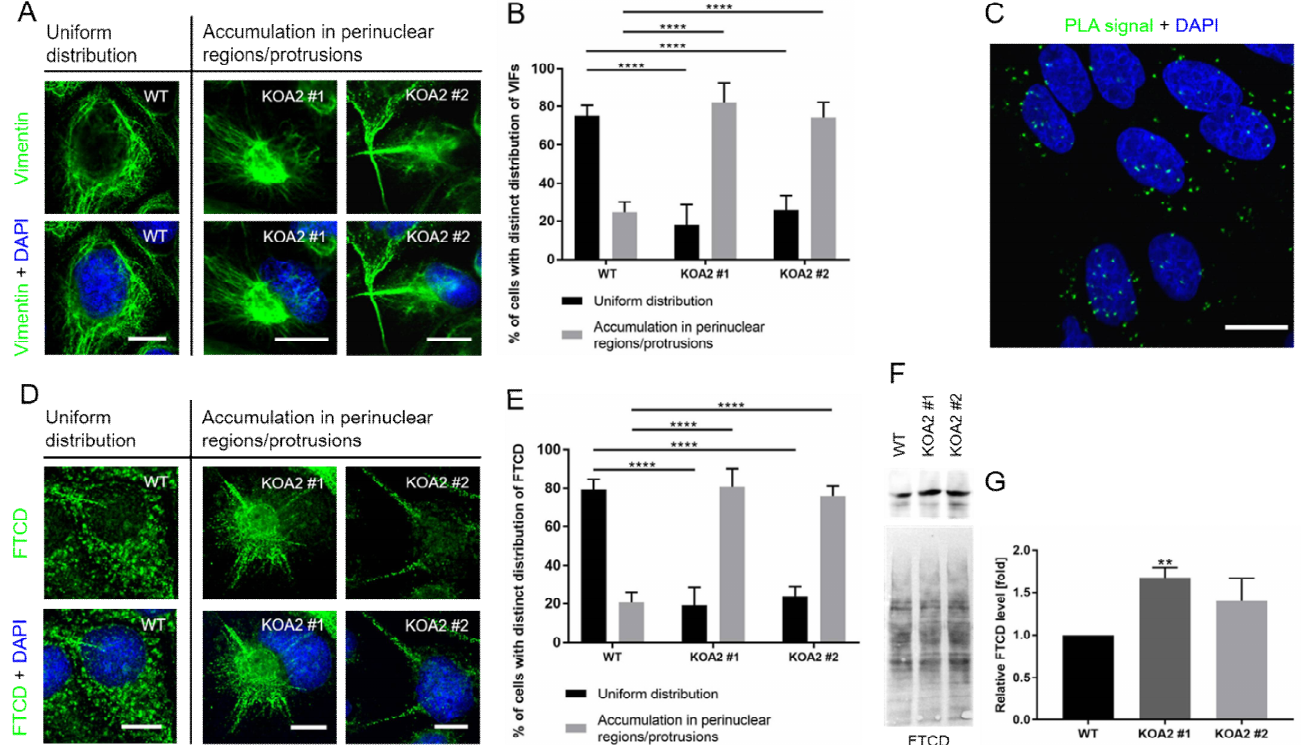
Figure 5. SLC35A2 deficiency affects organization of VIFs. ( A , D ) Representative images of distinct vimentin ( A ) and FTCD ( D ) staining patterns. VIFs ( A ) and FTCD ( D ) are shown in green and cell nuclei are shown in blue. Scale bar corresponds to 10 µ m. The way of data presentation was inspired by [41]. ( B , E ) Quantitative analysis of the percentage of cells with distinct distribution of VIFs ( B ) and FTCD ( E ) in the wild-type and SLC35A2 knockout cells. Data are presented as mean ± SD (6–9 images and 100 cells were analyzed for each cell line). Asterisks indicate statistically important differences between wild-type cells and individual clones. The significance level was set at p ≤ 0.0001 (****). Data were analyzed using ordinary one-way ANOVA with post hoc (Tukey’s multiple comparisons) test. ( C ) Results of in situ PLA analysis of proximity between FTCD and vimentin in the wild-type cells. PLA signals are shown in green and cell nuclei are shown in blue. Scale bar corresponds to 20 μm. ( F ) Western blotting analysis of the FTCD level. Ponceau S staining is presented alongside to demonstrate equal loading. Representative data out of several independent experiments are shown. ( G ) Densitometric analysis of the FTCD level ( n = 3). Data are presented as mean ± SD. Asterisks indicate statistically important differences between wild-type cells and individual clones. The significance level was set at p ≤ 0.01 (**). Data were analyzed using ordinary one-way ANOVA with post hoc (Tukey’s multiple comparisons) test.